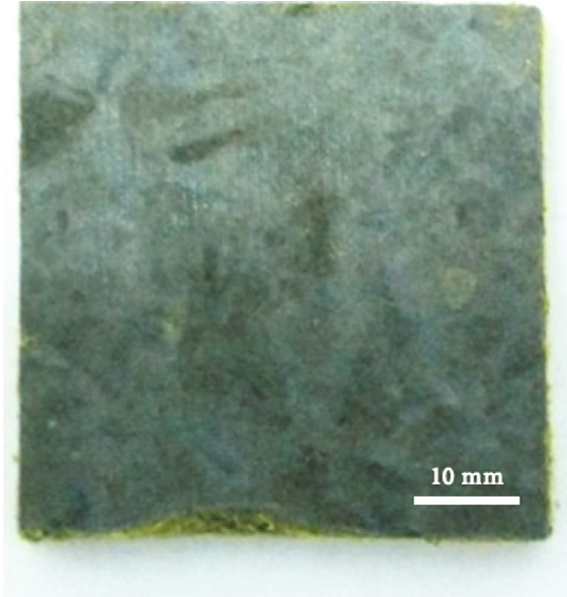
Figure 1: Morphology of the specimen before ablation.